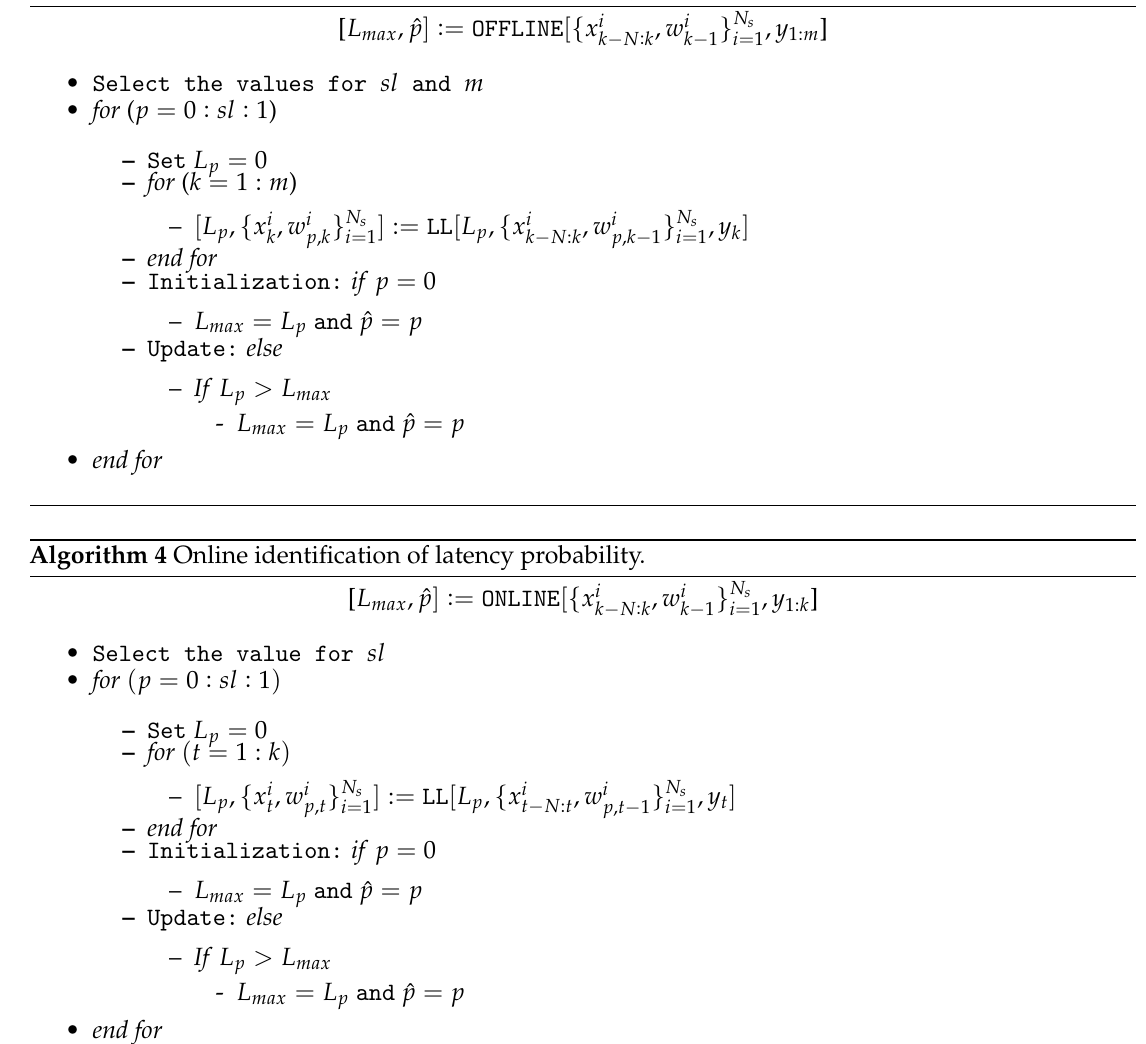
Algorithm 3 Offline identification of latency probability.